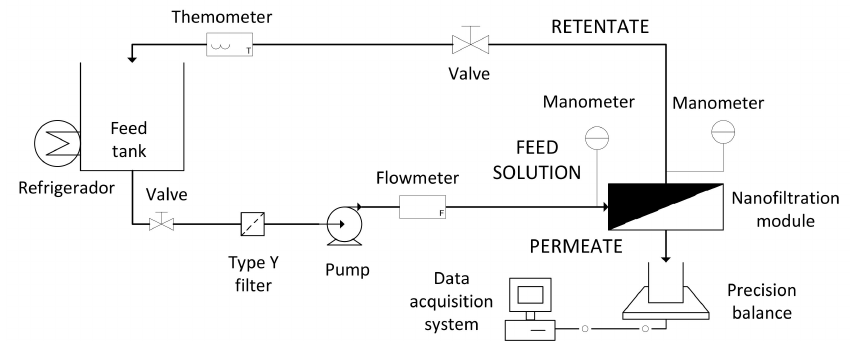
Figure 4. Schematic diagram of the nanofiltration (NF) laboratory